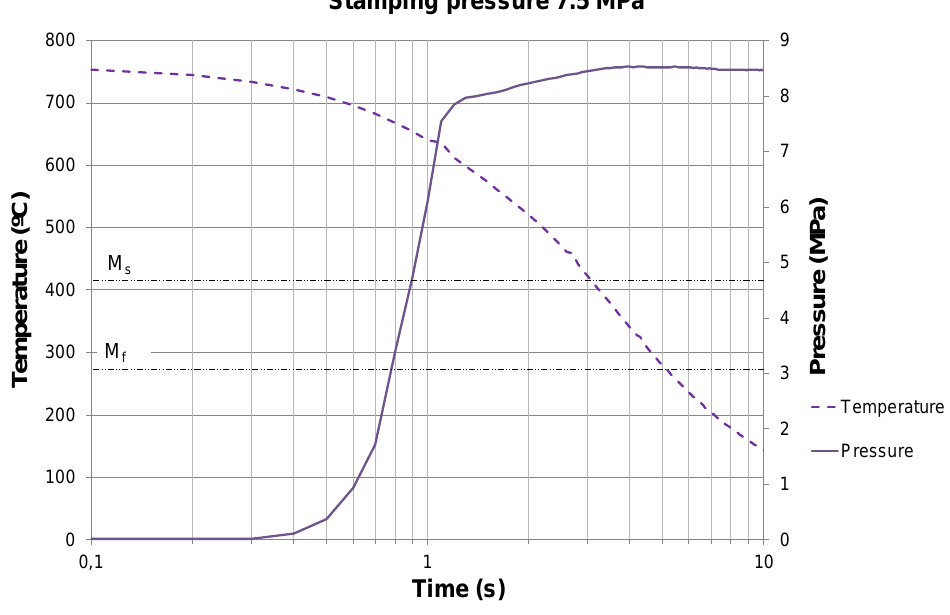
Figure 12. Temperature–pressure–time plot for a pressure set-point of 7.5 MPa.